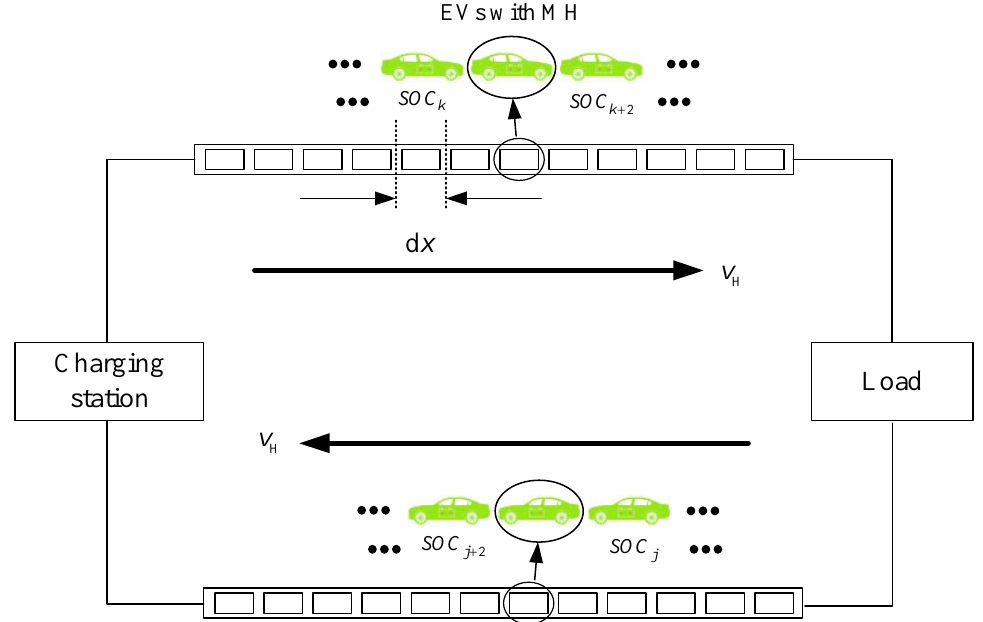
Figure 2. Schematic diagram of the MHES network.